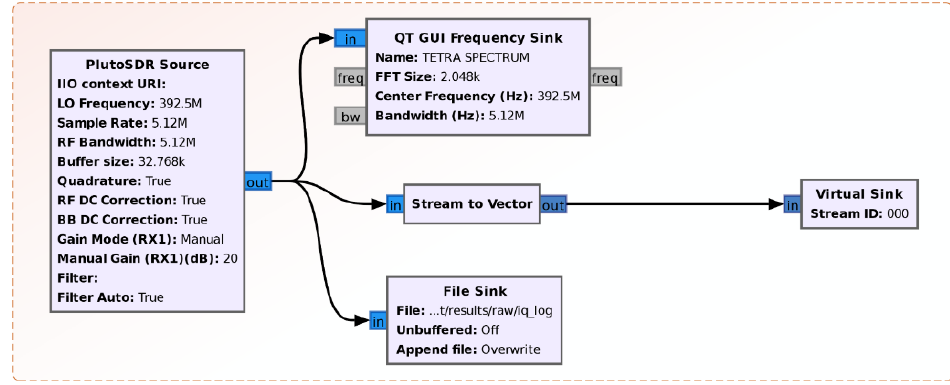
Figure 3. Radio interface module to SDR platform and data saving in IQ format.